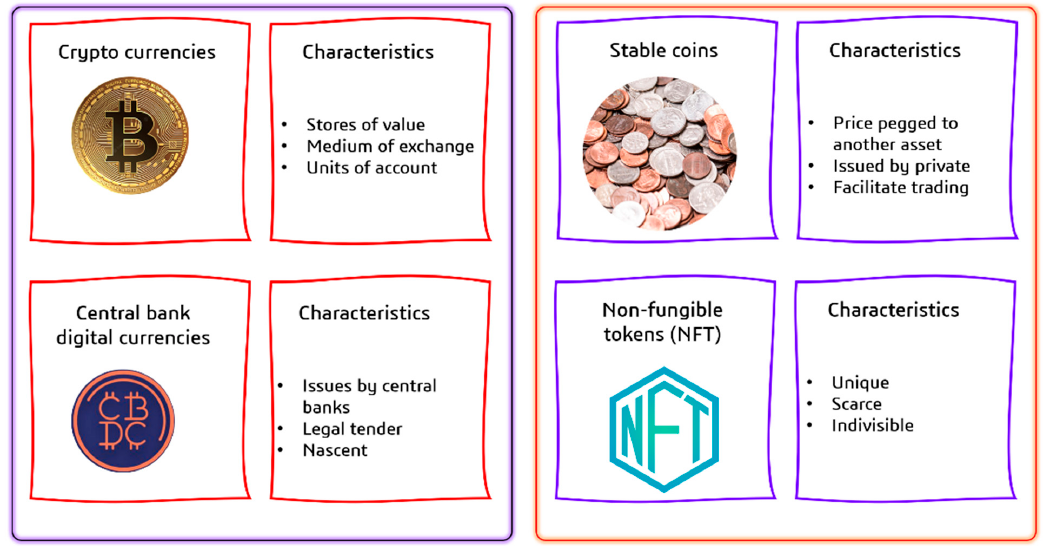
Figure 6. Different currencies and their characteristics.